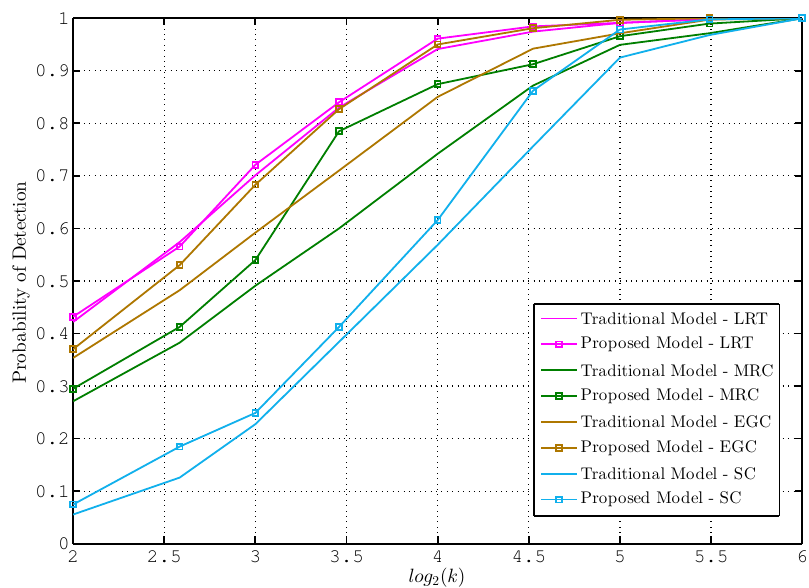
Figure 5. Probability of detection as a function of total number of sensors K, P d = 0.5, P f = 0.05, and the average channel SNR is 5 dB.